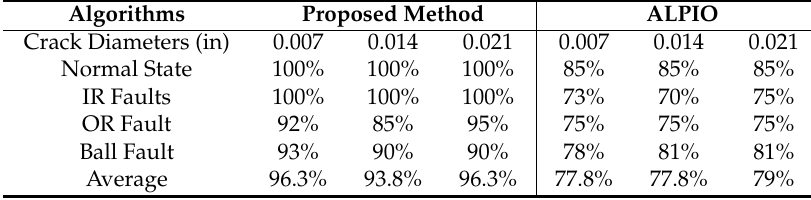
Table 5. Fault diagnosis results for Dataset 3 for the proposed method and ALPIO when torque load = 2 hp.